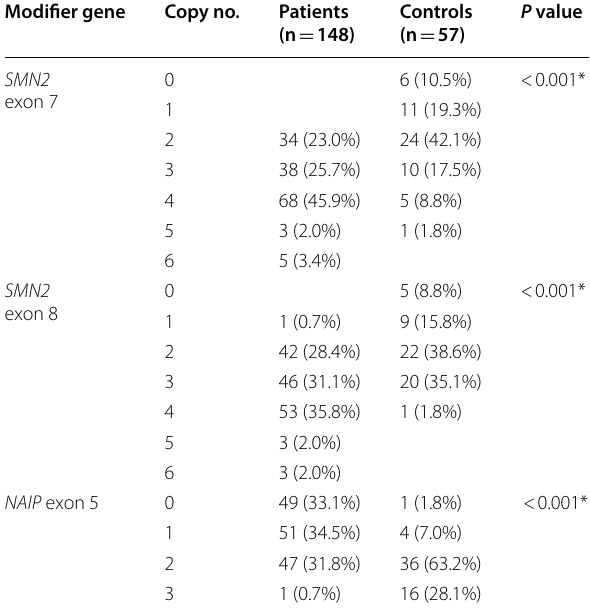
Table 2 Copy number variations of SMN2 and NAIP genes in controls (n 57) and SMA patients (n = deletion of exon 7 of SMN1 gene Modifier gene Copy